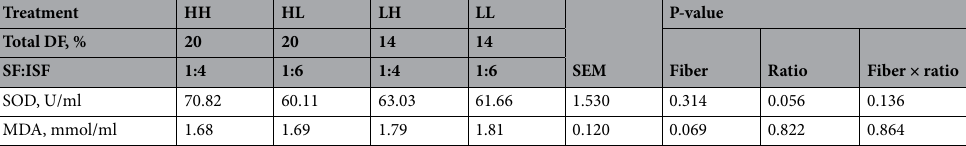
Table 1. Effects of total dietary fiber levels and soluble, insoluble dietary fiber ratio on serum oxidant, and antioxidant activity of sows. SEM standard error of means, SOD superoxide dismutase, MDA malondialdehyde, DF dietary fiber, SF soluble fiber, ISF insoluble fiber. a,b Means with different superscripts within rows are significantly different at (P <